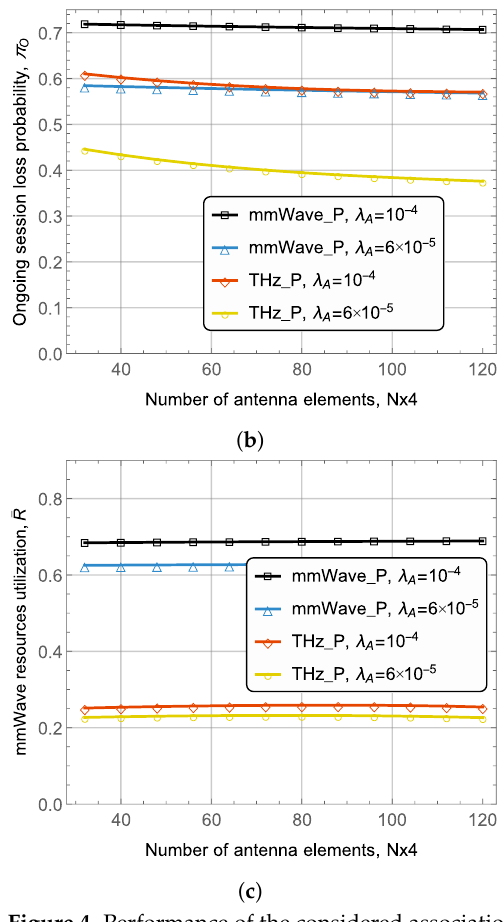
Figure 4. Performance of the considered association schemes as a function of the number of antenna elements at THz BS. ( a ) New session loss probability, ( b ) Ongoing session loss probability, ( c ) System resource utilization, R